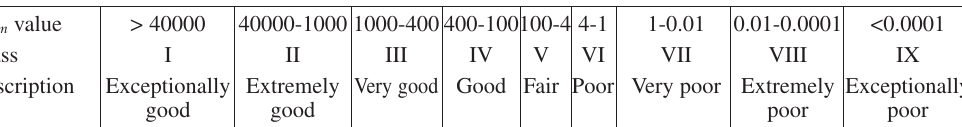
Table I. Q srm classification